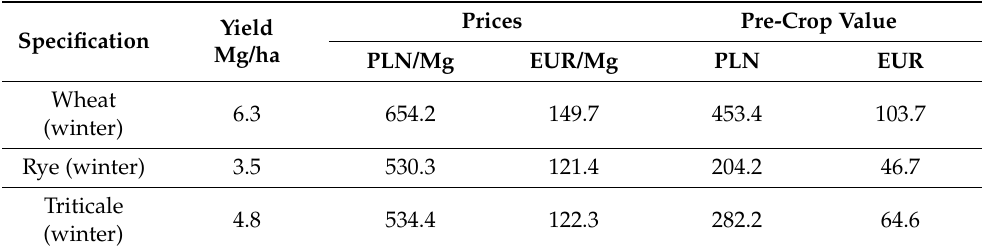
Table 7. Average yields and prices of grain wheat, triticale, rye, and pre-crop value after rape in